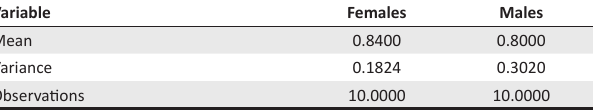
TABLE 7: Contralateral transient evoked otoacoustic emission’s suppression data for females and males ( n = 40).